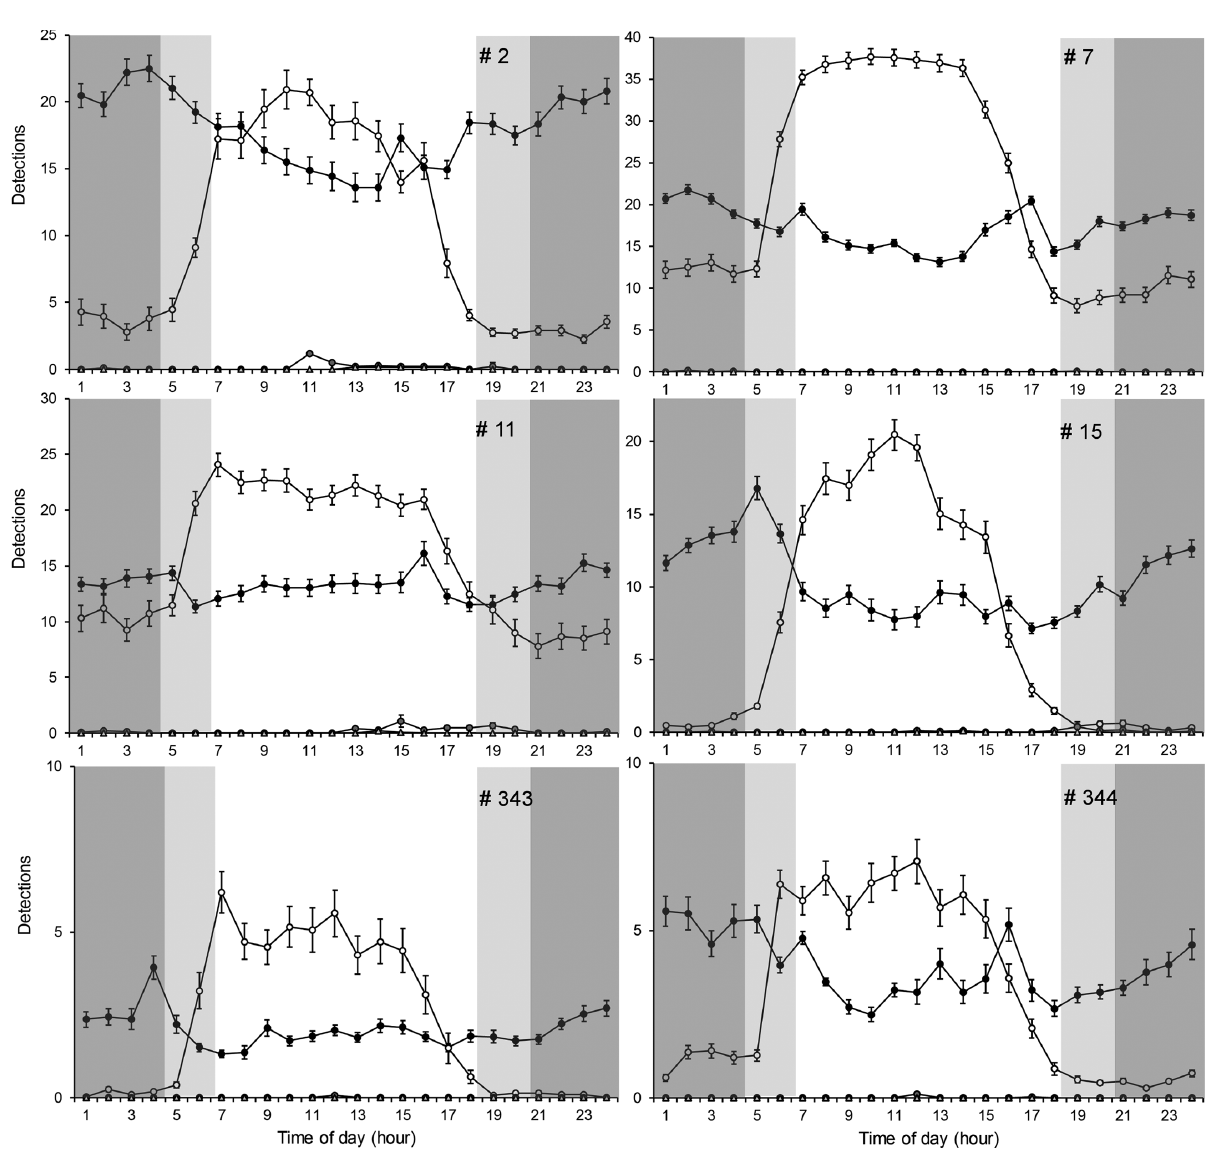
Fig. 5. Mean (±SE) number of detections per receiver group of released Sparus aurata tagged with acoustic transmitters (IDs 2, 7, 11, 15, 343, and 344) over the 24 h of the day. The receiver at the farm ( d ), receivers in the farm-impacted area (I1, I4, and I5) ( s ), the central area of the bay (M8, M9, M10, U6, and U7) ( d ), and the outer part of the bay (O12, O13, O14, O15, and O16) ( m ). Dark grey plot areas represent nighttime, and light grey areas represent sunrise and sunset periods. Selected individuals recorded for >1 mo within the study array show typical daytime activity patterns in the farm-impacted area. See also Fig. S2 in the Supplement. Note different y -axis Daily detections at the farm showed significant = 3.85, p < variation between the 24 h period (F 23,276 = 10.16, p < 0.01) and the day−night period (F 1,12 0.01), although there was no difference between the = 0.49, p > feeding and non-feeding periods (F 1,12 0.05). Interestingly, a positive correlation was ob - served between the number of detections and swim- ming depth (r = 0.67, p < 0.01), where fish movements closer to the surface were accompanied by a reduced number of detections.